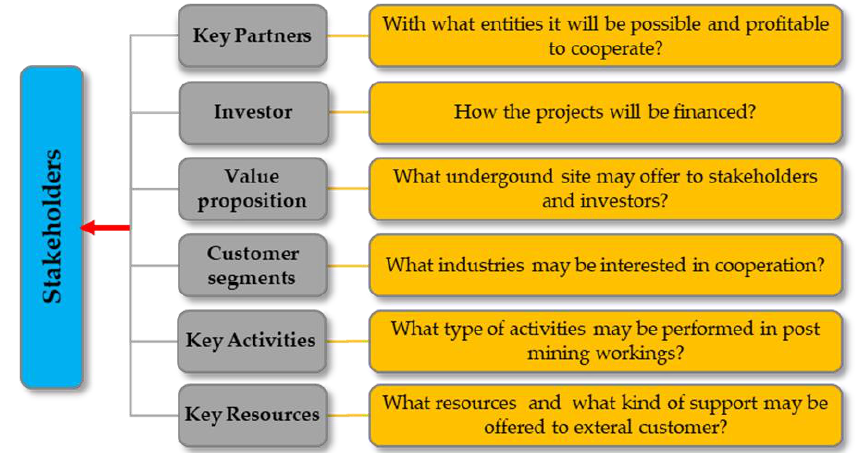
Figure 6. The topics which need to be solved during the identification of stakeholders.